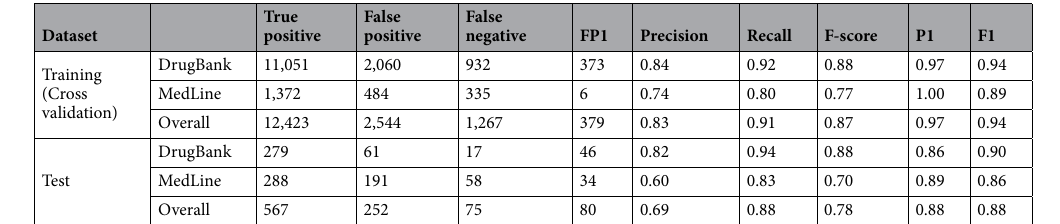
Table 1. Performance of Chemicals and Drugs lexicon.